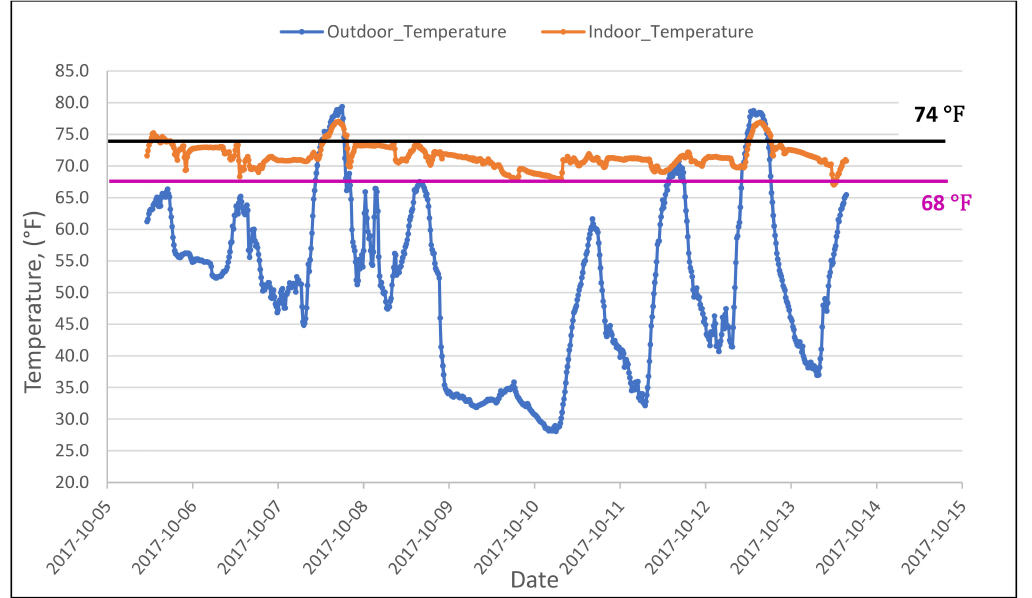
Figure 6. The indoor temperature of the house vs. outdoor air temperature and the acceptable temperature